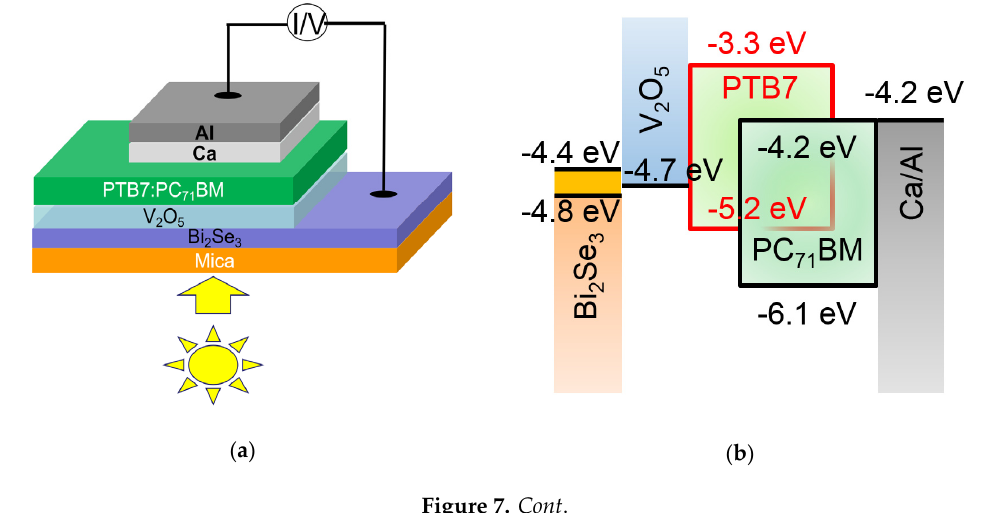
( c ) Figure 7. The Bi 2 Se 3 -based organic optoelectronic device. ( a ) Schematic diagram of the device structure; ( b ) energy band alignment; ( c ) I – V characteristics. 4. Conclusions High-quality Bi 2 Se 3 thin films have been prepared on a mica substrate via vdW epitaxial growth. The film exhibited a highly c-axis-oriented growth with an extraordinary crystallinity, reflected by a narrow XRD rocking curve FWHM of ~317 arc seconds. At the same time, fence-like planes with Bi 2 Se 3 (015) parallel to the mica (001) surface emerged, which was explained by using the interface model associated with the CSLU concept developed especially for vdWE. To eliminate the fence-like planes, an amorphous Bi 2 Se 3 buffer layer prepared at the substrate temperature of room temperature was applied, prior to the Bi 2 Se 3 crystal growth. As a result, only the Bi 2 Se 3 (001) growth direction with vdW gaps parallel to the substrate showed up, with a smoother surface than that without the amorphous buffer layer. However, this suppression in the fence-like planes sacrifices to a certain degree the crystal lateral growth alignment, mirrored by a broadening phi scan peak FWHM. A high Hall mobility of 1761 cm 2 /(Vs) for Bi 2 Se 3 on mica was obtained at ~12 K, and 697 cm 2 /(Vs) at room temperature with a nearly constant sheet electron density of ~1.0 × 10 14 cm − 2 . By applying an amorphous Bi 2 Se 3 buffer layer, the carrier density was reduced to about half that without the buffer layer. The mobility at room temperature was boosted to 726 cm 2 /(Vs), and linearly increased to 1469 cm 2 /(Vs) as the temperature dropped to 12 K. An optoelectronic device consisting of a Bi 2 Se 3 /mica TCE, organic absorber, and Ca/Al metal back electrode was designed and prepared, generating a